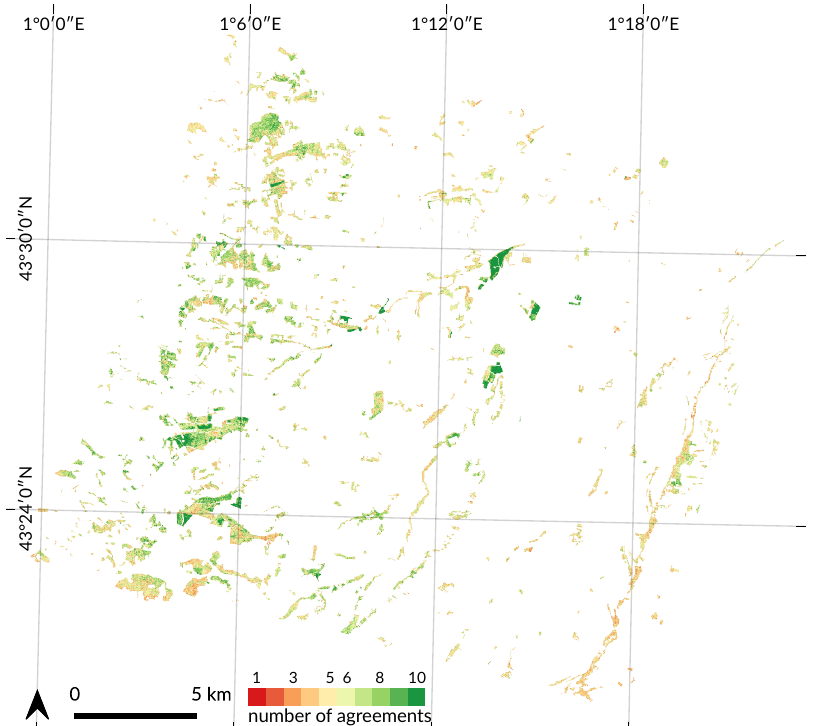
Figure 9. Spatial comparison between the annual classifications of forest tree species from 2006 to 2014 (including 2006bis). The number of agreement is the modal value related to the class with the highest frequency. This map illustrates the stability of predictions from one year to another with a high number of disagreements in red (high uncertainty) and a low number of disagreements in green (high accuracy). In many cases, homogeneous green areas are tree plantations of broadleaf species such as Red Oak and Aspen or